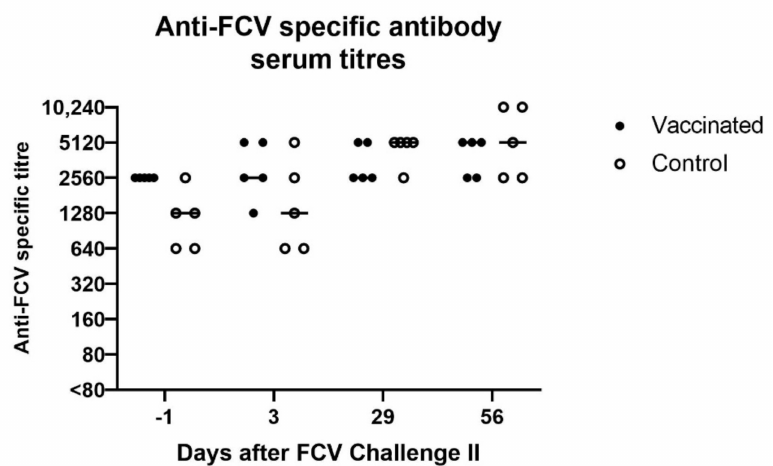
Figure 13. Dot plot of anti-FCV specific antibody serum titres measured by IFA before and after FCV Challenge II in vaccinated and control cats, respectively. Antibody titres reflect the reciprocal of the last serum dilution showing positive fluorescence in the IFA. Each dot represents the titre of a cat of the vaccine or control group, respectively. The horizontal bar represents the